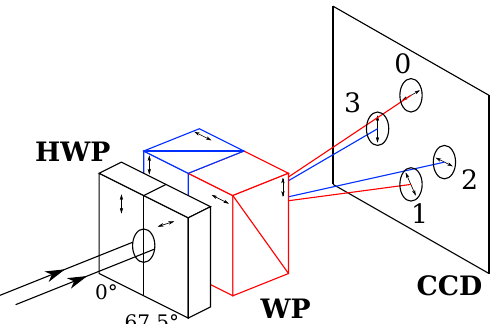
Figure 1. Schematic of the polarizing optics of RoboPol. The array of two half-wave plates (HWP) and two Wollaston prisms (WP) is shown. The fast optical axes of the elements and the polarization planes of the rays are shown with arrows. The HWP with the fast axis oriented at 67.5 ◦ rotates the polarization plane by 2 · 67.5 = 135 ◦ (see, e.g.,